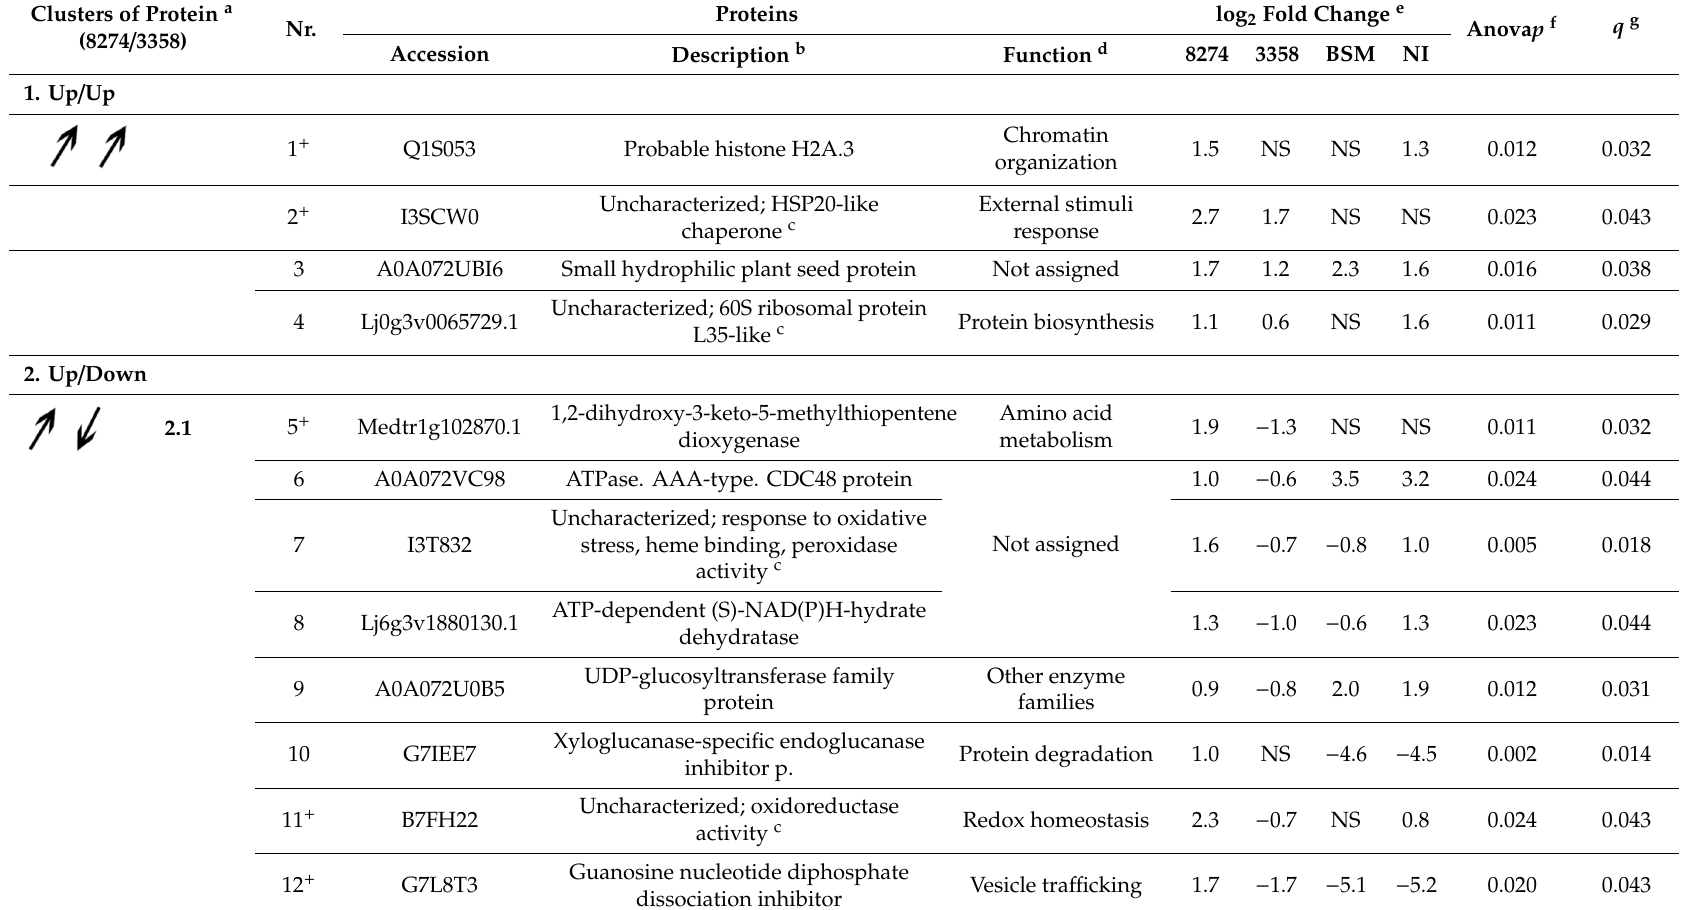
Table 1 Differentially expressed pea proteins, identified in the seeds of P. sativum lines K-8274 and K-3385, characterized with a high and low EIBSM, respectively, and grown in presence and absence of a complex symbiosis with Rhizobium leguminosarum bv. viciae (strain RCAM 1026) and R. irregularis strains BEG144, BEG53, and S7. Clusters of Protein a